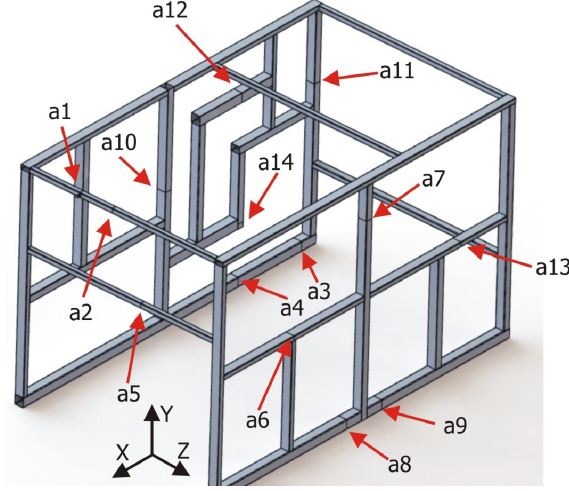
Figure 7. Sections used to characterize the validation structure, identified as a1 to a14.